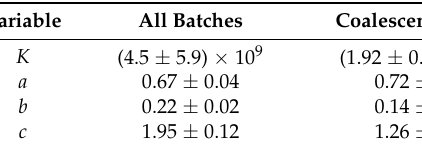
Table 5. Empirical constants for Equation (15).